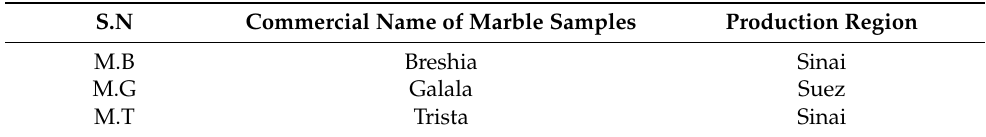
Table 1. The samples, marking, and description.